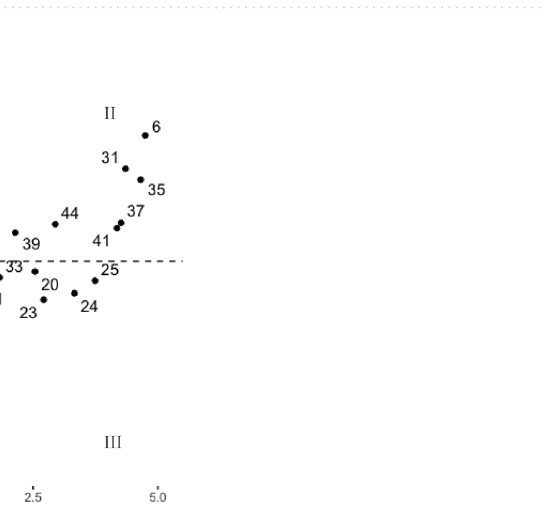
Figure 2. Plots of loadings for the 17 QBA analyzed terms. ( A ) Terms plotted on the first principal components PC1 (positive high arousal index) and PC2 (negative high arousal index). ( B ) Terms plotted on PC1 and PC3 (positive low arousal index).